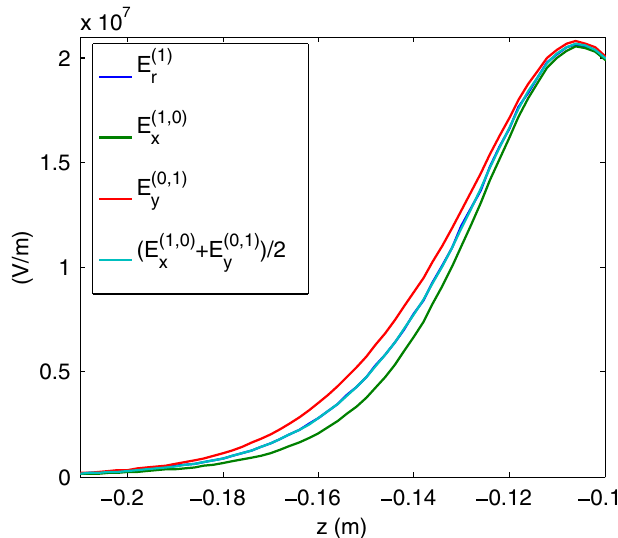
and E in the coupler x y